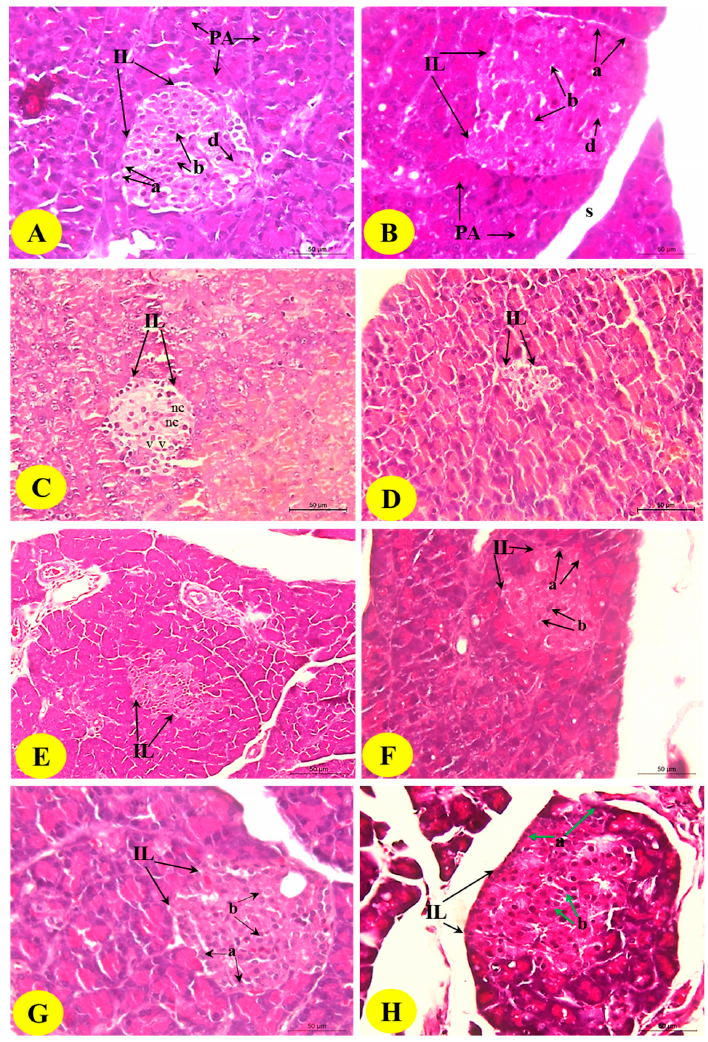
Figure 5. Photomicrographs of the H&E-stained pancreas of the normal ( A , B ), diabetic control ( C , D ), and diabetic rats treated with the B . aegyptiaca fruit ( E , F ) and seed extracts ( G , H ). Photomicrographs A and B show normal pancreatic lobules consisting of pancreatic acini and intact islets of Langerhans (IL) with alpha (a), beta (b), and delta cells. Photomicrographs C and D show the islets of Langerhans with the reduced size and smaller number of the cells; the islets exhibited necrosis (nc) and vacuolations (v) (H&E stain: Scale bar = 50 µm). Photomicrographs E–H show considerable improvements in the islets of Langerhans with a greater increase in the islet size and the number of islet cells. The islets also exhibited cytoplasmic vacuolations (v) and necrosis (nc) (Figure 5; Pho- tomicrographs C and D). The islets of Langerhans exhibited nearly normal and organized treated with the B . aegyptiaca fruit (Figure 5; Photomicrographs E and F) and seed extracts (Figure 5; Photomicrographs G and H) compared with those in the diabetic control rats; the seed extract was found to be the most